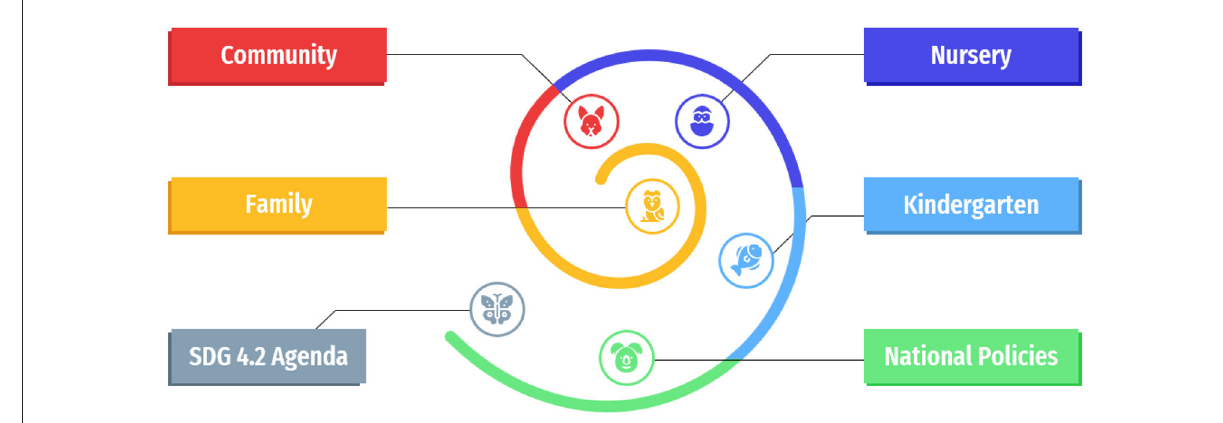
FIGURE4 Model of Six layered components for implementing inclusive and qualitative ECEC